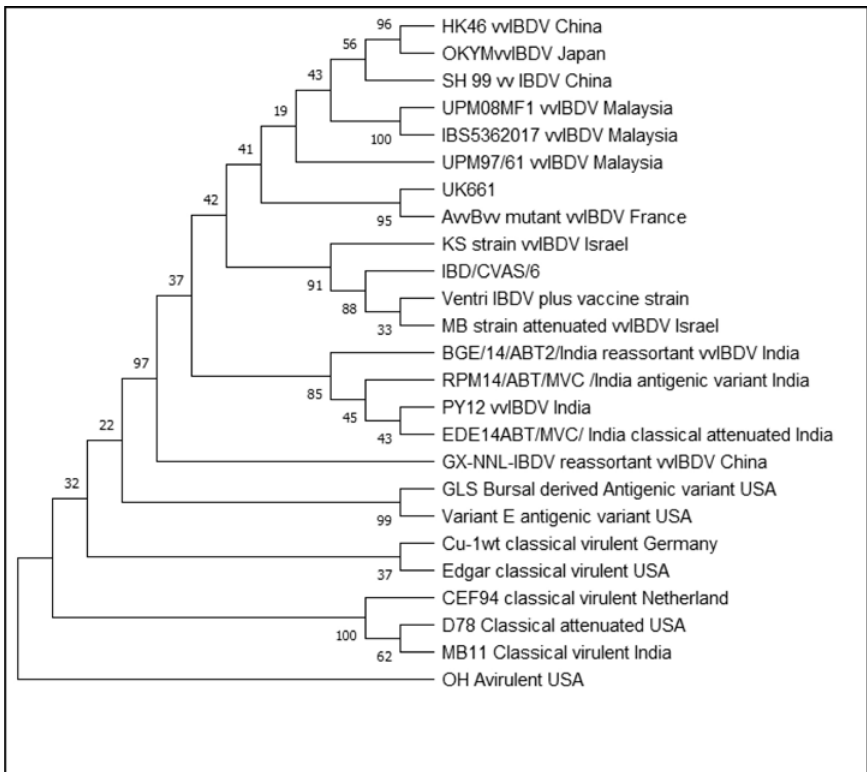
Fig.5. Phylogenetic tree based on the analysis of 1332 bp nucleotides of VP2 gene substitution at S745N could have a role in the change in virulence of the attenuated vaccine strain virus as 745N is not a novel variation and is noticed in other strains of IBDV. This shows the significance of characterisation